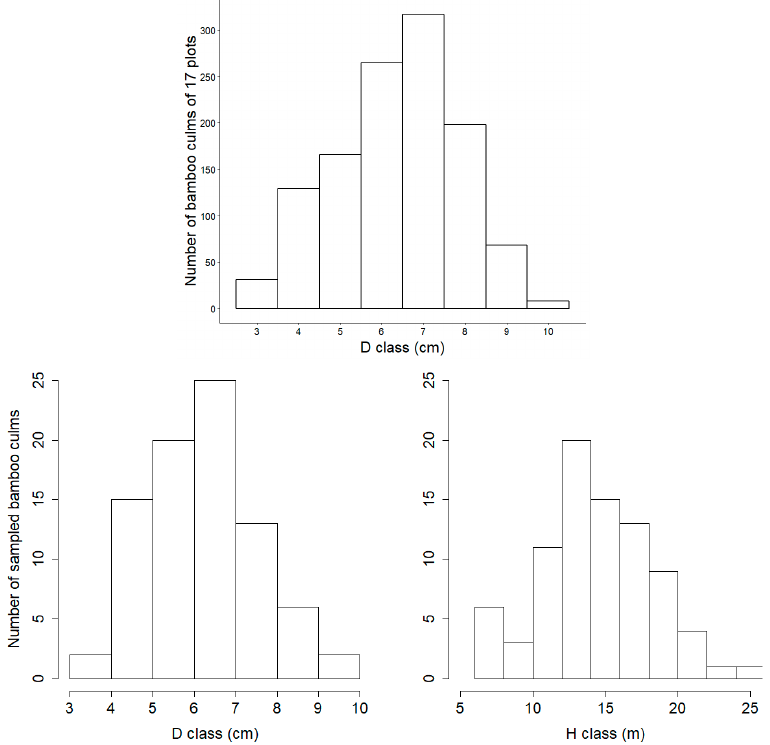
Figure 2. Top: Distribution of bamboo culm diameter ( D , cm) of 17 sample plots of 100 m 2 . Bottom: Distribution of bamboo culm diameter ( D , cm) and bamboo culm height ( H , m) of destructively-sampled bamboo culms.